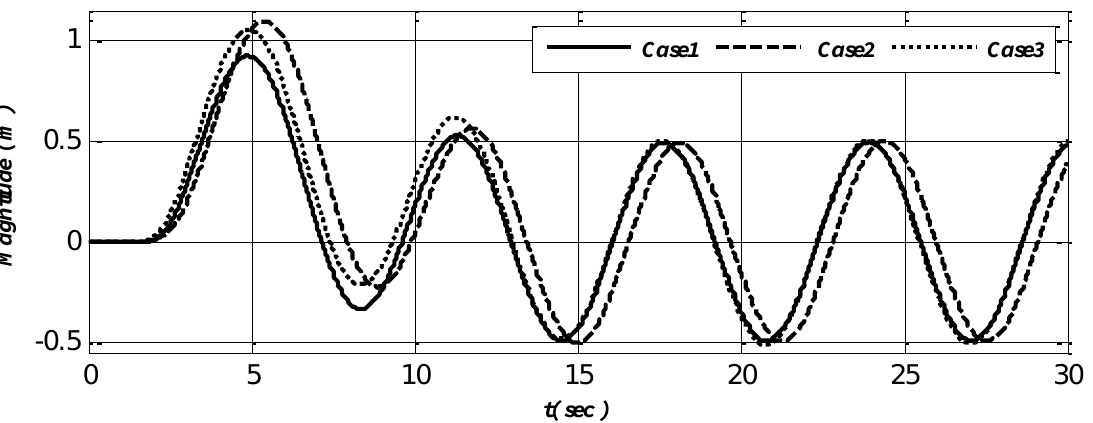
Figure 12c. Position of slave system for sinusoidal input ( x s )